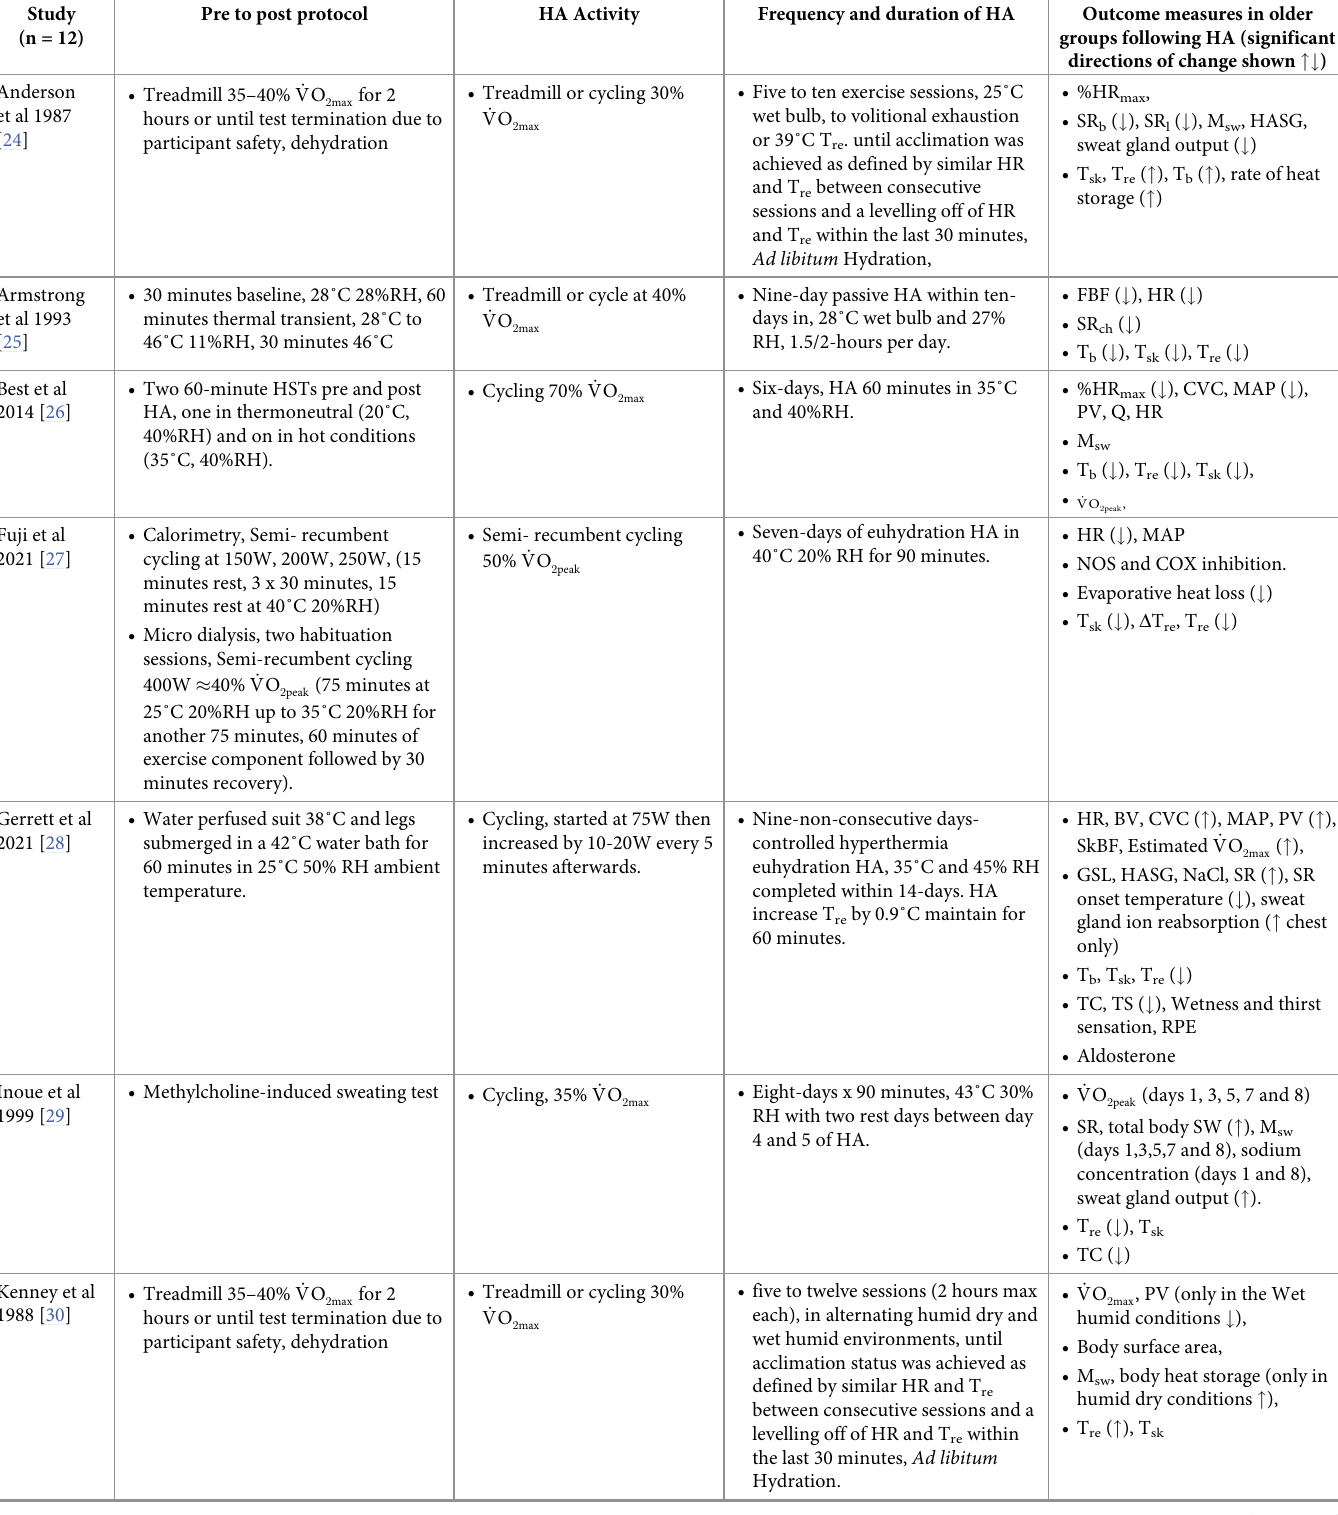
Table 2. Heat acclimation activity, frequency and duration of heat acclimation and outcome